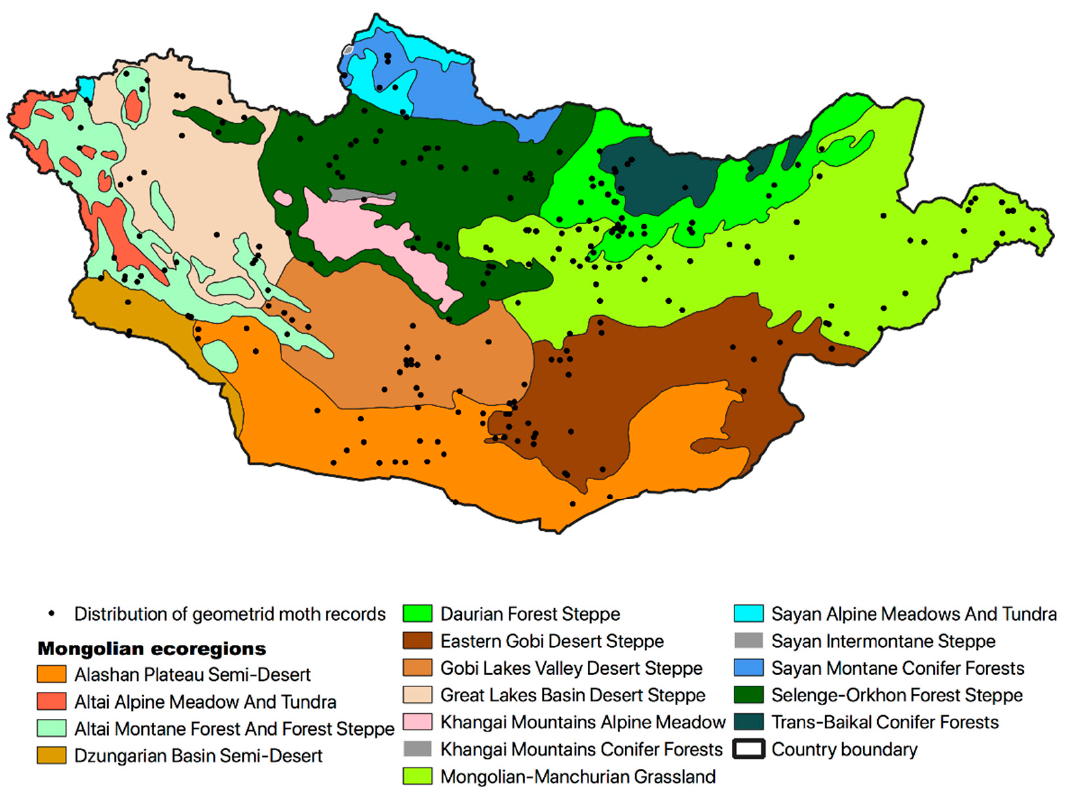
Figure 1. Mongolian 14 ecoregions with distribution of 1557 geometrid moth records (211 of 1973 records are missing exact locations, 205 records were sampled at the same location, but at different time period). For two small ecoregions (marked in gray), there is no scientific knowledge of geometrid moths.